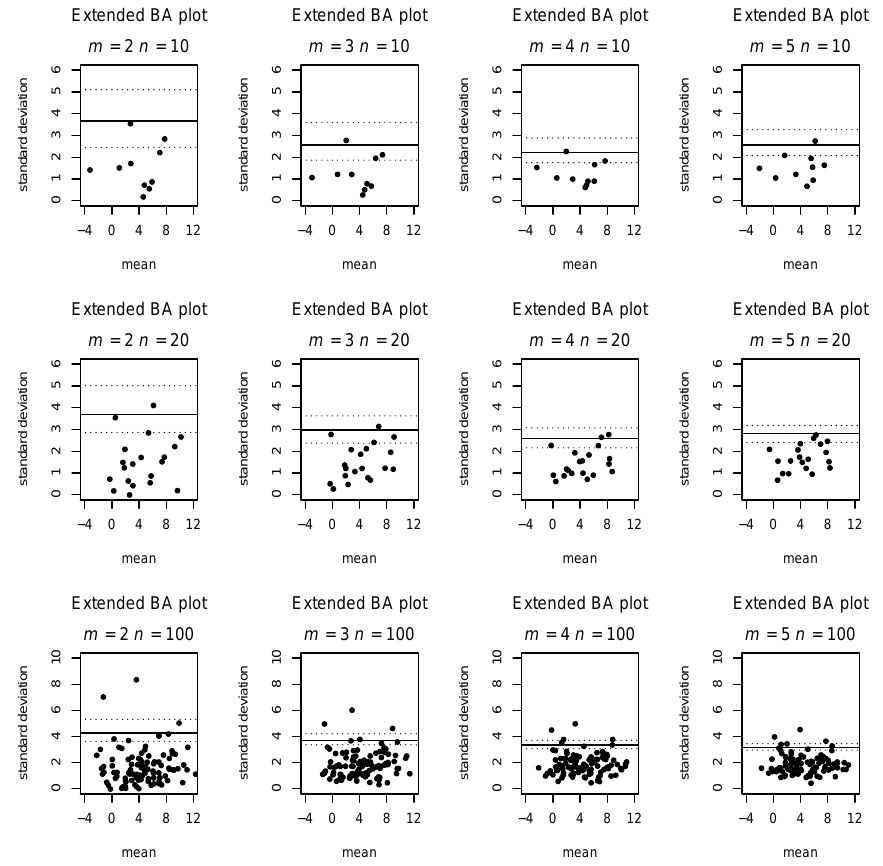
Figure 2. Extended BA plot for varying number of raters and observed subjects based on simu- lated